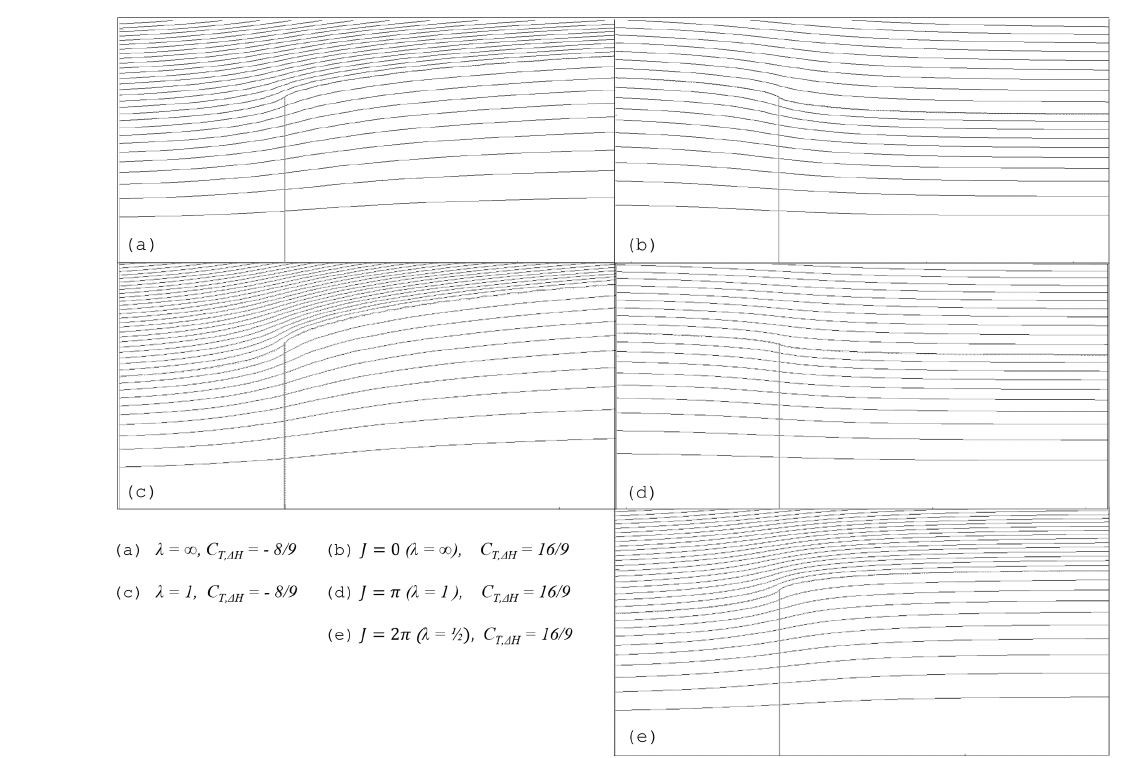
Figure 4. The flow patterns of wind turbine discs (a) and (c) and propeller discs (b) and (d) with a contracting wake, (e) with an expanding wake. The streamlines indicate stream tube values increasing with (cid:49)(cid:57) = 0 . 1 (cid:57) 1